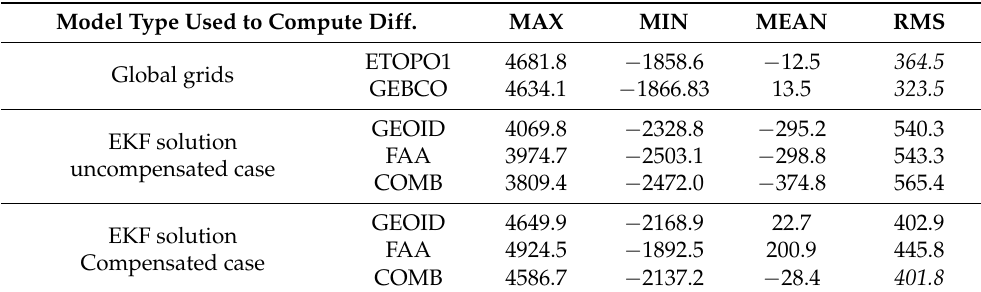
Table 1. Values of Global Bathymetric Models minus ship-track soundings and EKF solutions minus ship-track soundings. Units are meters.